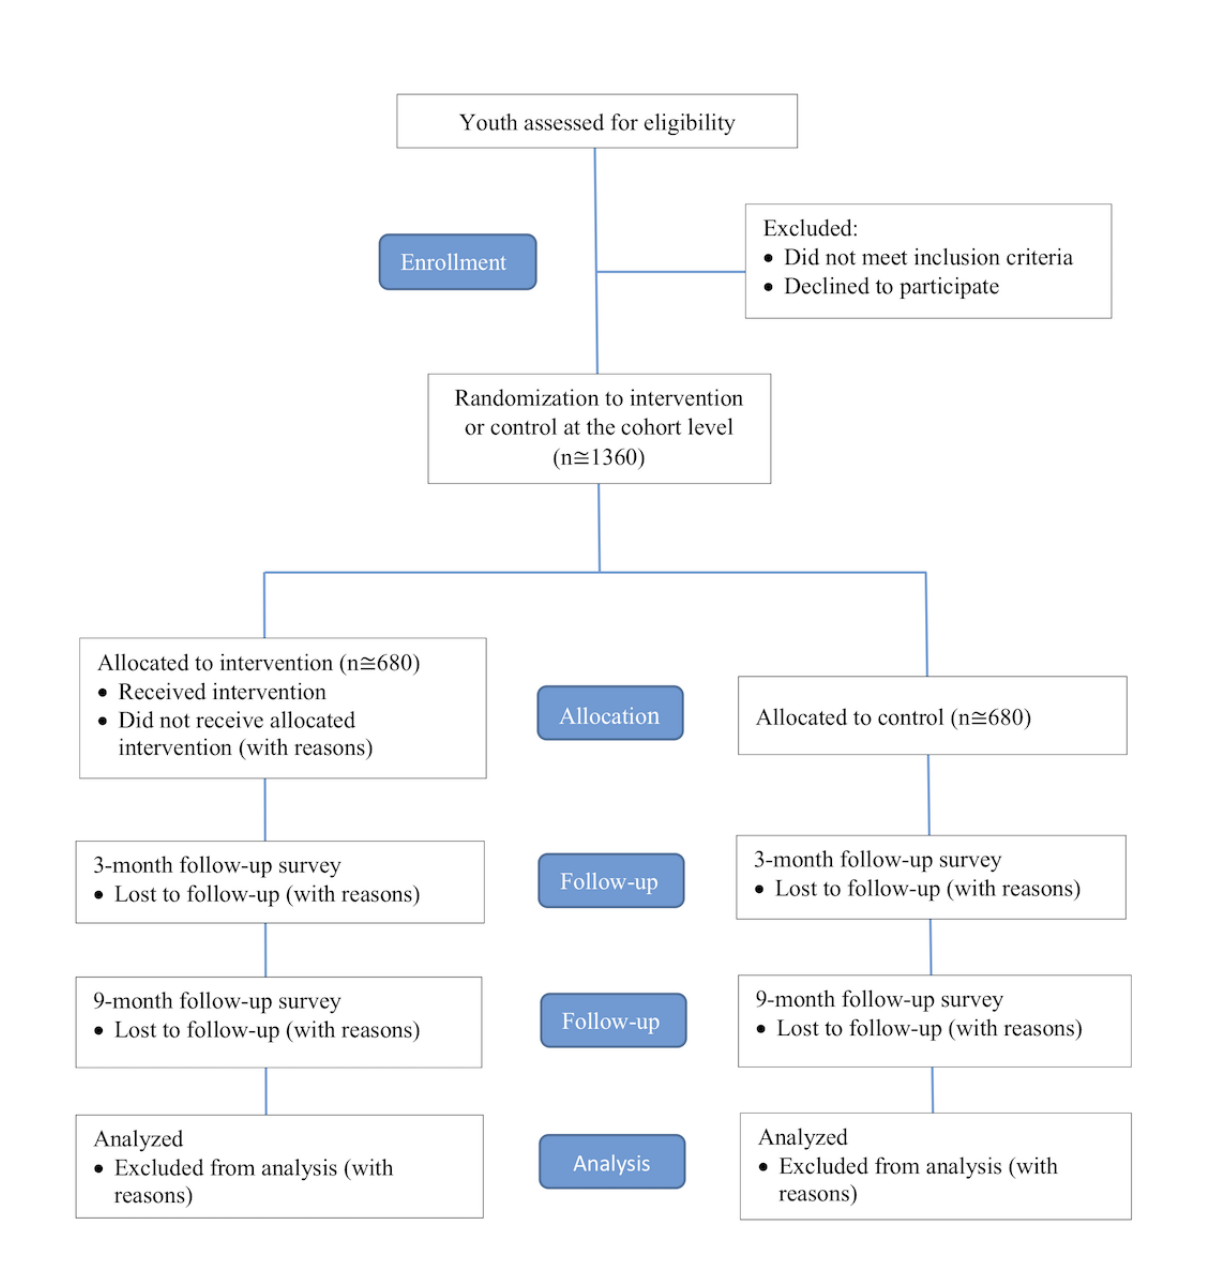
Figure 2. Consolidated Standards of Reporting Trials (CONSORT) flow